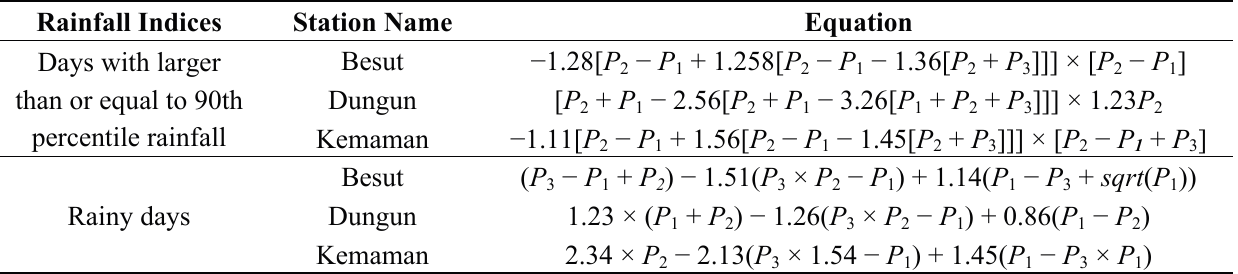
, P and P are given in Table 1 2 3